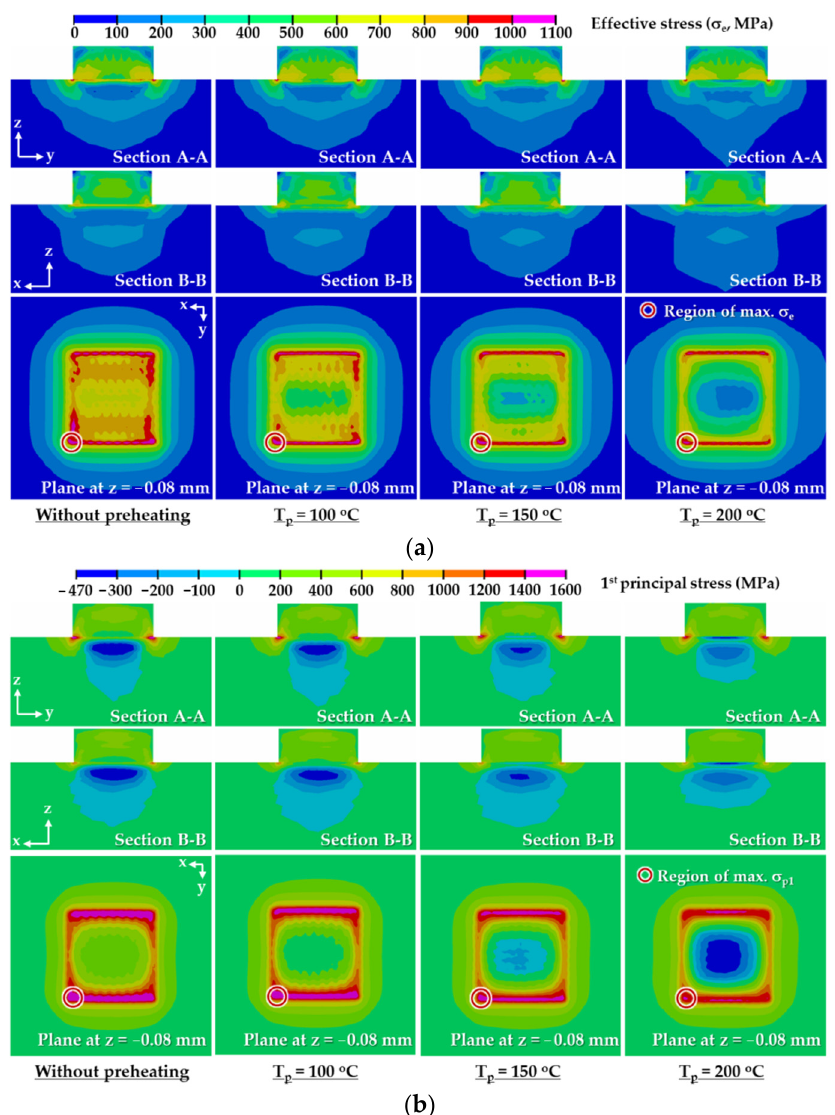
Figure 15. Residual stress distributions for different preheating temperatures (after the completion of cooling): ( a ) effective stress distributions; ( b ) first principal stress distributions.